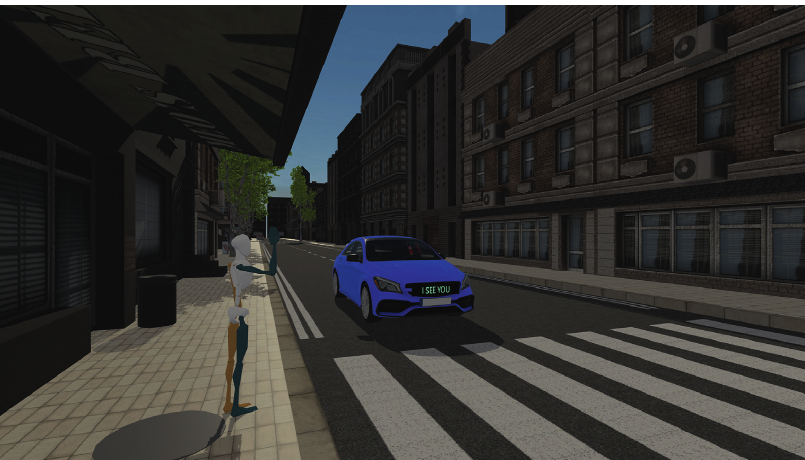
Figure 1: VR environment with AV displaying “I SEE YOU.” The participants’ body was visualized using an avatar. During the experiment, participants could see the avatar (e.g., hands and feet) from a first-person perspective while wearing the head-mounted